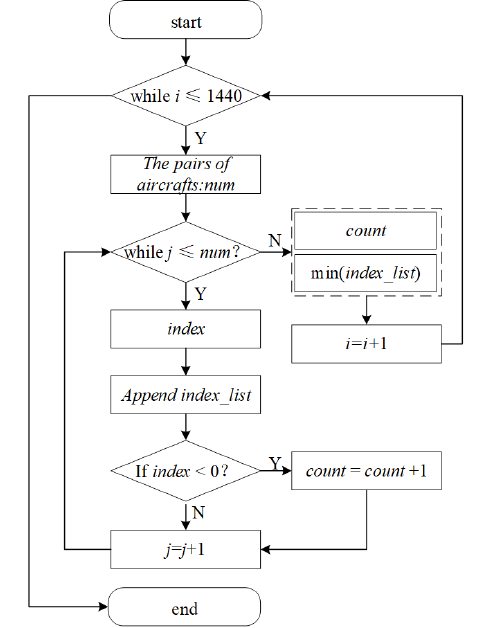
Figure 3. Calculation process of safety